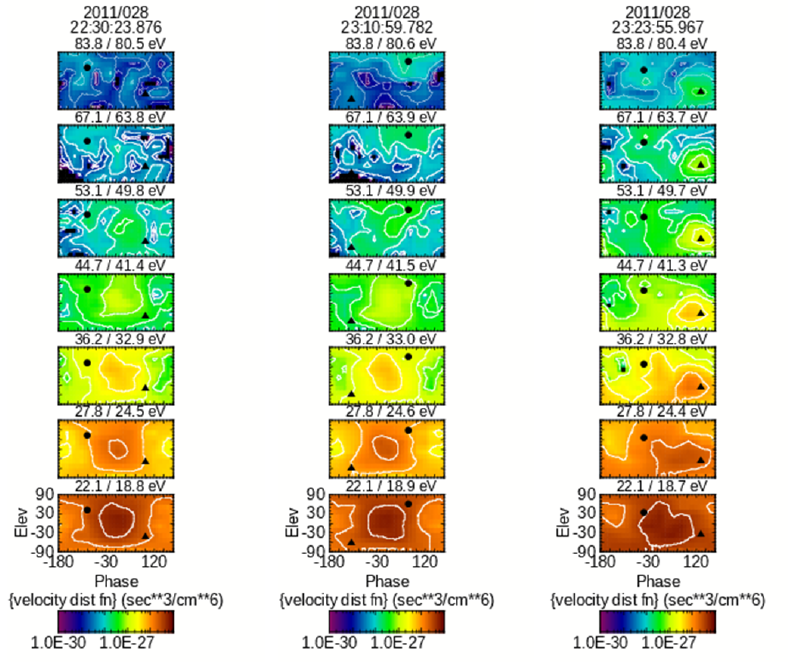
Figure 10. Three sets of φ – θ plots from the event in Figs. 8 and 9. Red arrows in Fig. 9 show the locations of the data in each column of plots. The last two columns of plots are from foreshock intervals. The first shows no strahl, but both have return electron populations.